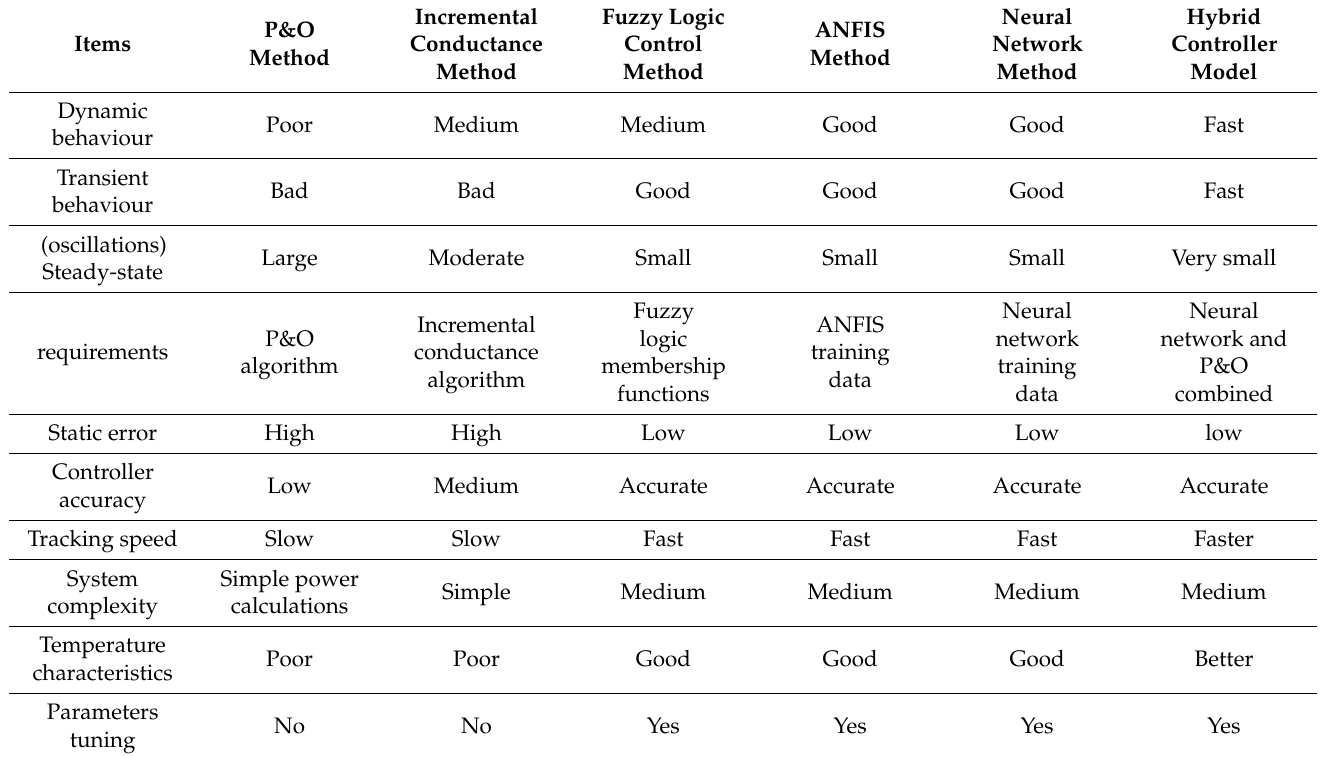
Table 5. Comparison of various methods in various parameters.